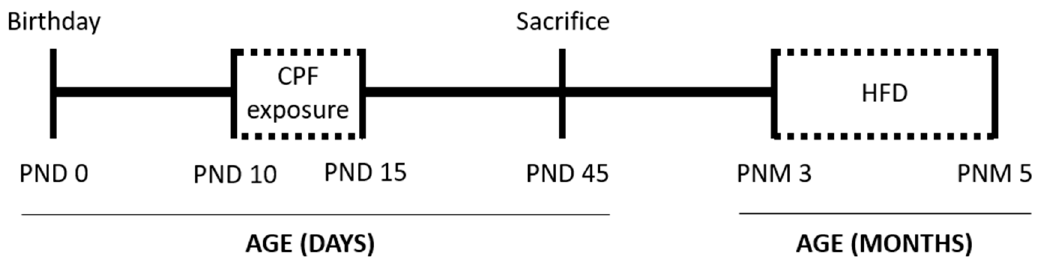
Figure 1. Experimental timeline including the treatment period from postnatal days (PND) 10 to 15 and sacrifice to obtain biological samples at PND 45. At postnatal month (PNM) 3, the animals were subjected to the high-fat diet (HFD) until PNM 5. Abbreviations: CPF: chlorpyrifos.